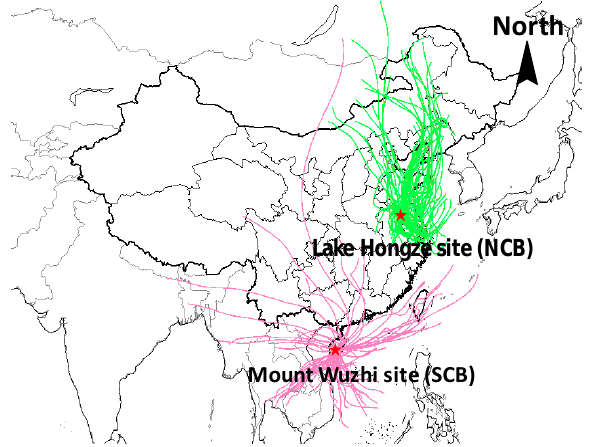
Figure 1. Locations of the Lake Hongze site (NCB) and Mount Wuzhi site (SCB). The green and pink lines represent the typi- cal 48h near-ground (100m above ground level) air mass back- trajectories during the sampling campaigns.